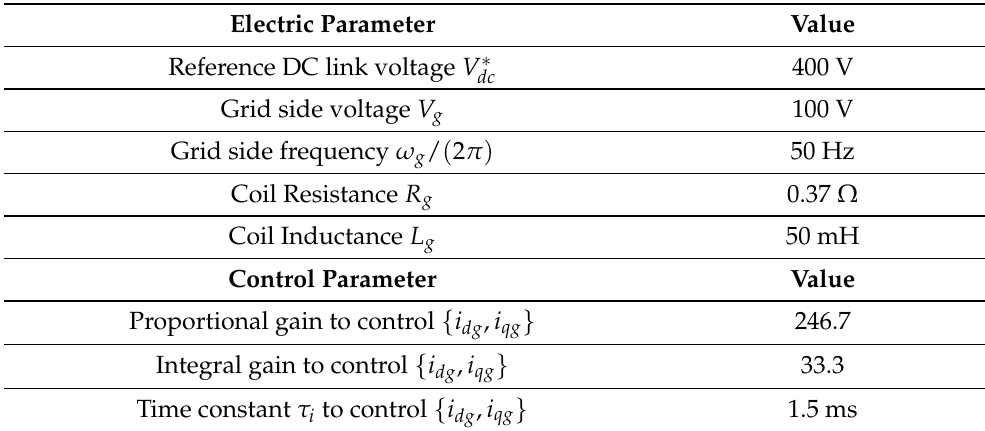
Table 1. Common electric and control parameters for the grid side converter in all simulations and experiments.